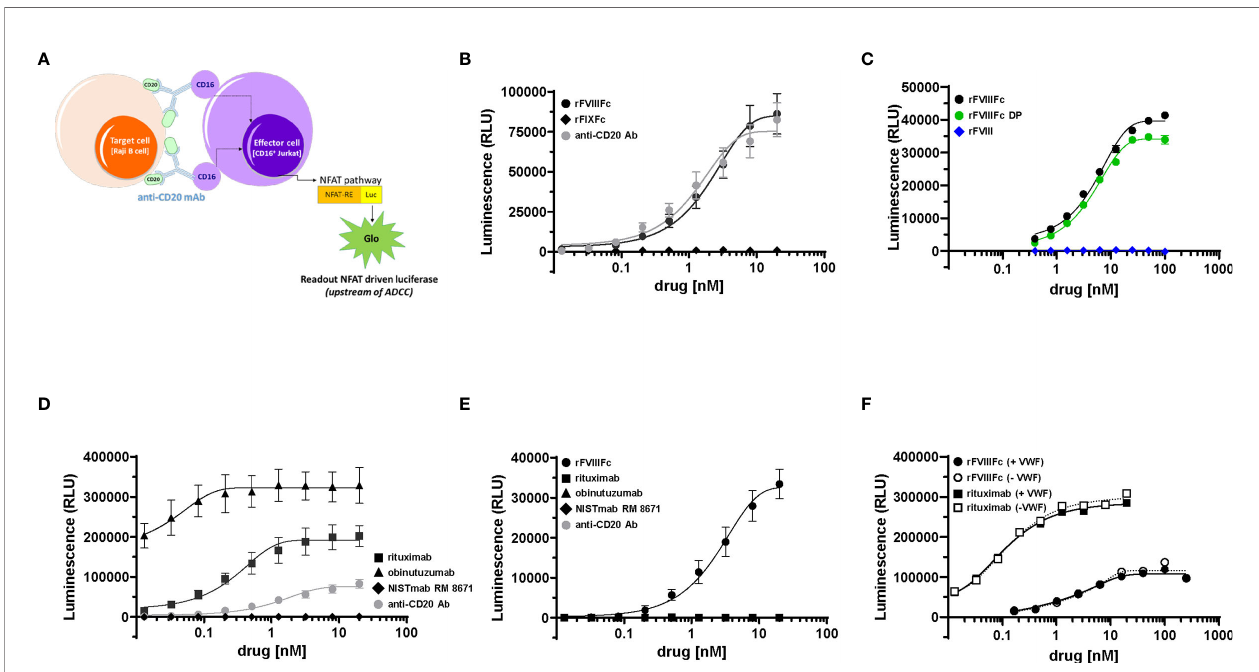
FIGURE 1 | rFVIIIFc signals via CD16. (A) An illustration depicting the ADCC Reporter Bioassay used to measure CD16-mediated responses to human IgG1 Fc- containing therapeutic protein products or control antibodies. (B) ADCC Bioassay Target Cells (1.25 x 10 4 CD20 + Raji B-cells) were incubated with a dilution series (20 nM – 13.1 pM) of therapeutic Fc-fusion proteins (rFVIIIFc, black circles; rFIXFc, black diamonds) or anti-CD20 assay control antibody (grey circles) and then incubated with ADCC Bioassay Effector Cells (7.5 x 10 4 ) for 6 hours at 37°C. Following incubation, Bio-Glo Luciferase Assay Reagent was added, and luminescence was determined using a Perkin Elmer Victor X3 2030 plate reader. Plotted as mean relative luminescence units (RLU) ± standard error of mean (SEM) (n = 2-3) from two independent experiments. (C) ADCC Reporter Bioassay conducted as described above with dilution series (100 nM – 391 pM) of rFVIIIFc protein (black circles), rFVIIIFc DP (green circles), or rFVIII (blue diamonds); plotted as mean ± SEM (n = 2-4) from a representative of two experiments. (D) ADCC Reporter Bioassay conducted as described above with monoclonal antibodies as controls (rituximab, black squares; obinutuzumab, black triangles; NISTmAb RM 8671, black diamonds; anti-CD20 assay control antibody, grey circles); plotted as mean ± SEM (n=2-3) from two independent experiments. (E) ADCC Reporter Bioassay conducted as described above, except in the absence of ADCC Bioassay Target Cells (rFVIIIFc, black circles; rituximab, black squares; obinutuzumab, black triangles; NISTmAb RM 8671, black diamonds; anti-CD20 assay control antibody, grey circles); plotted as mean ± SEM (n = 2) from a representative of two experiments. (F) ADCC Reporter Bioassay experiment conducted as described above, except assay buffer constituents RPMI 1640 Medium and 4% Low IgG fetal calf serum were replaced with AIM-V serum free medium + 2 nM VWF (solid lines/closed symbols) or AIM-V serum free medium (dashed lines/open symbols) (rFVIIIFc, circles; rituximab, squares); plotted as data points (n = 1) from a representative of two